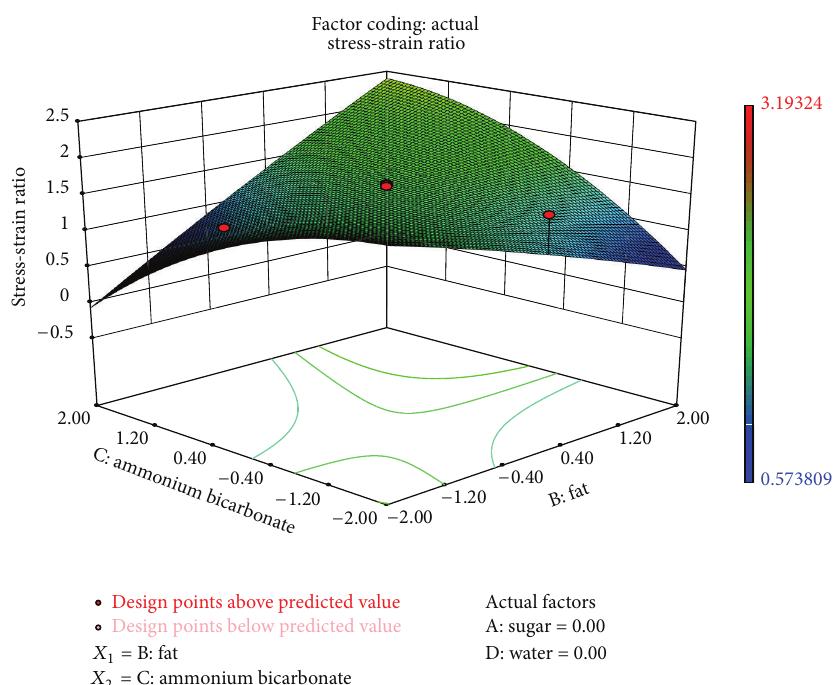
Figure 5: Surface plots representing the effect of fat ( 𝑋 2 ) and ammonium bicarbonate ( 𝑋 3 ) on stress-strain ratio of the biscuits.